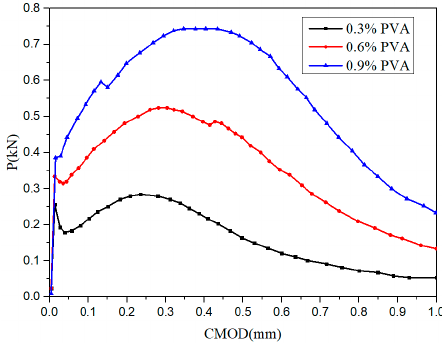
Figure 11. Effect of the PVA fiber content on the P-COMD curve [65]. Figure 11. E ff ect of the PVA fiber content on the P-COMD curve [65].